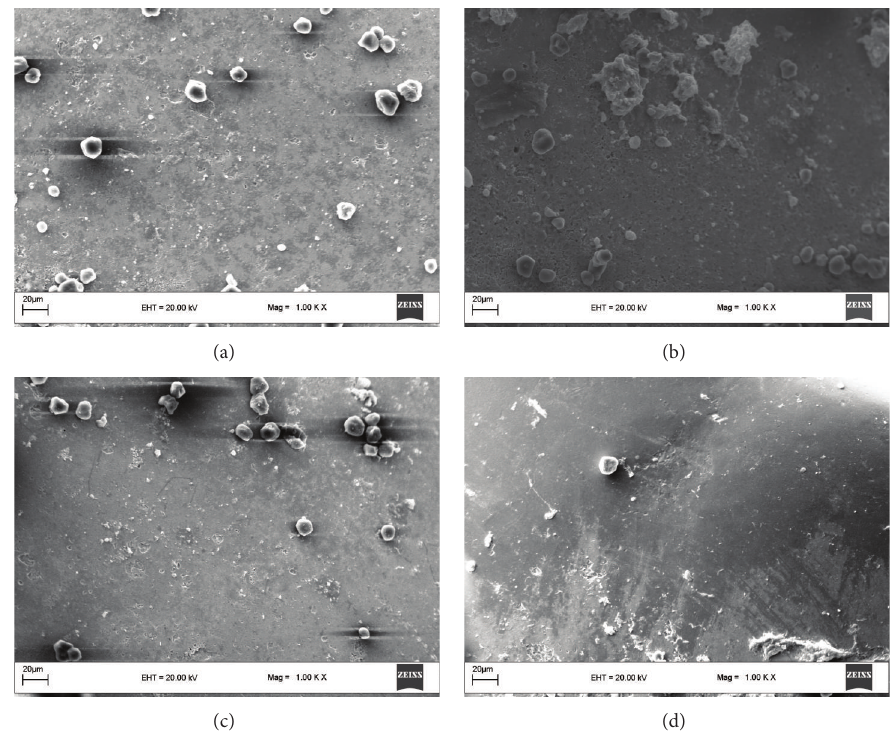
Figure 2: SEM images (1000x magnification) of the specimens from (a) Er:YAG laser, (b) control, (c) ACP, and (d) TCP.